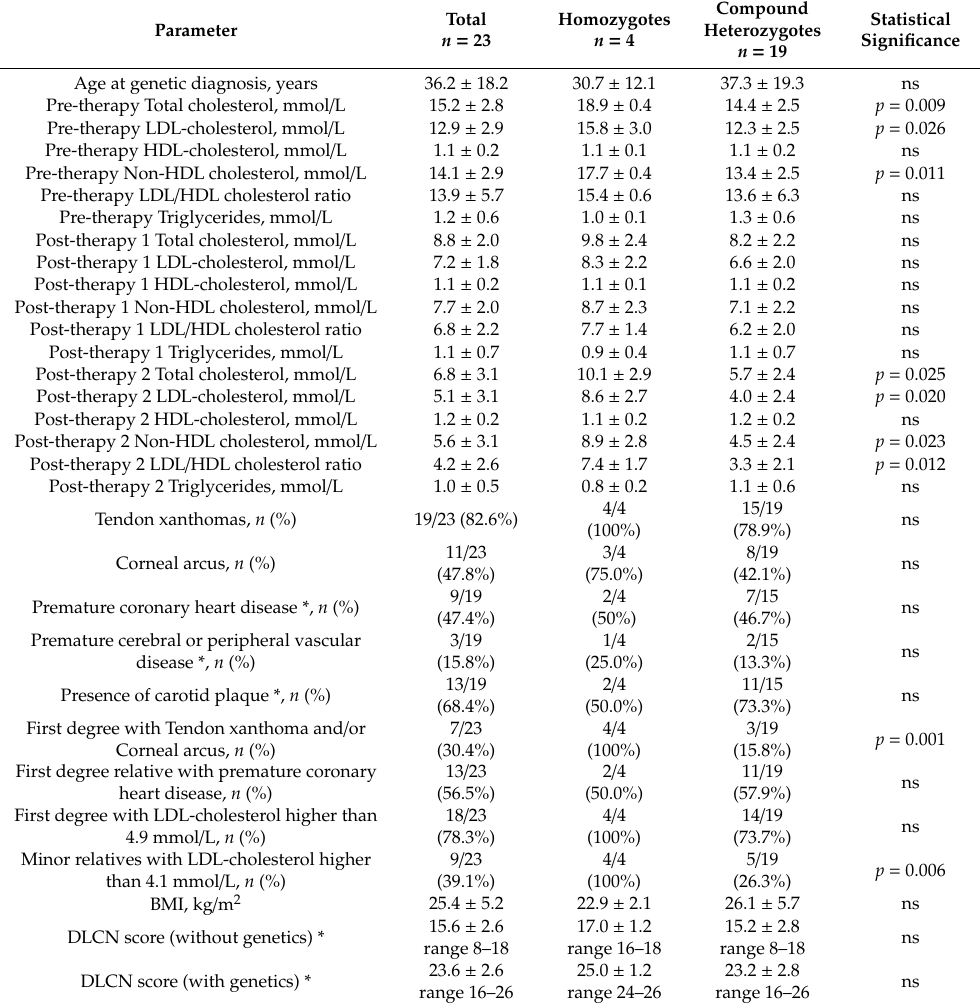
* Premature coronary heart disease, premature cerebral or peripheral vascular disease, and presence of carotid plaque and DLCN scores were reported only for 19 adult patients (four homozygotes and 15 compound heterozygotes); ns: not significant; BMI: Body Mass Index; DLCN: Dutch Lipid Clinic